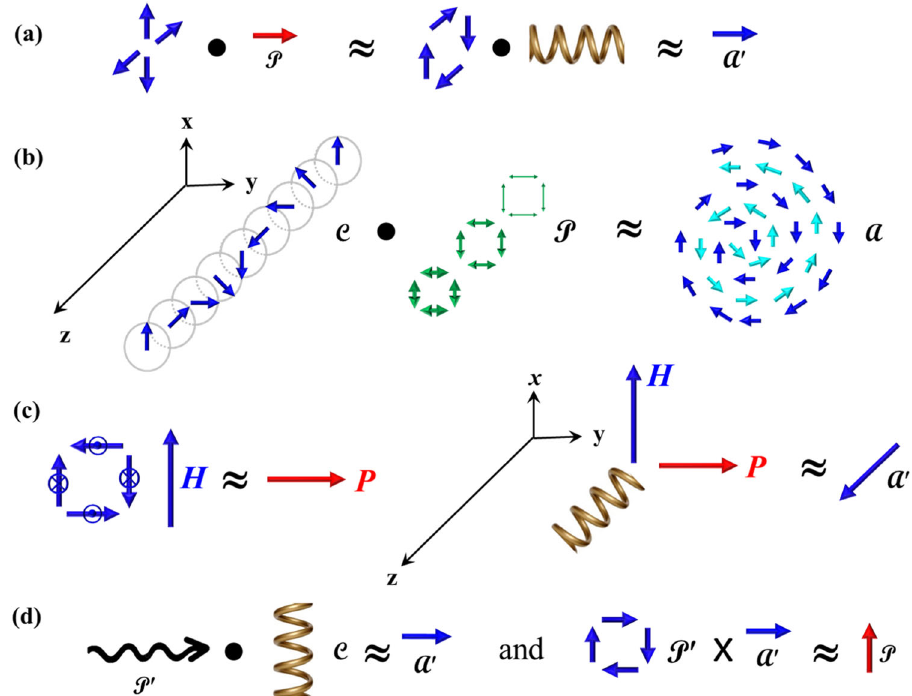
Fig. 2 Emergent phenomena of various objects, mostly spin textures, in the presence of external perturbations. Green double arrows with different thickness show a strain gradient. Other symbols have the same meaning as Fig. 1. a Magnetic monopole combined with polarization and toroidal moment combined with crystallographic chirality result in magnetization. b Helical spin order in the xy plane under strain gradient along z results in spiral magnetic superstructure. Blue and cyan arrows display spins with different directions. c The left cartoon shows how polarization ( P ) can be induced in “ Type-I magnetic quadrupole + alternating canted moments ” by magnetic fi eld ( H ). These P and H result in a toroidal moment along z , and crystallographic chirality combined with this toroidal moment results in magnetization along z , as shown in the right cartoon. d Electric current fl ow to chirality (crystallographic or magnetic chirality) produces magnetic fi eld along the current direction, and this magnetic fi eld acting on the magnetic toroidal moments of skyrmions or “ toroidal moment + a canted moment ” results in voltage gradient along the transverse direction, which is the origin of the so-called topological anomalous Hall effect in conducting specimens. In addition, the right-hand-side SOS relationship leads to the off-diagonal linear magnetoelectricity of toroidal moment in insulating